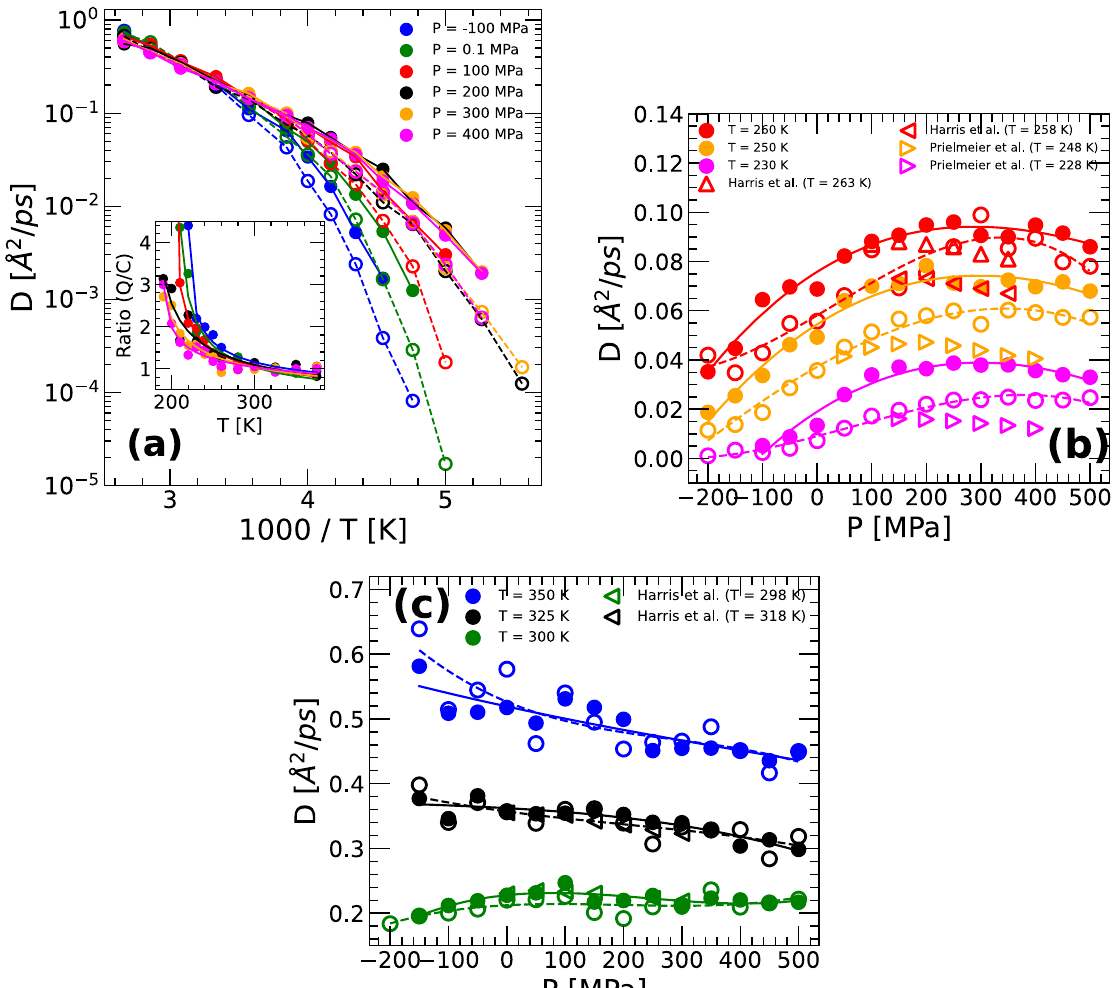
Figure 6. ( a ) Diffusion coefficient of q-TIP4P/F water as function of temperature at selected pressures. Results from RPMD simulations are indicated by solid circles; empty circles are results from classical MD simulations. Inset: ratio of the diffusion coefficients obtained from RPMD and MD simulations shown in the main panel. The inclusion of NQE increases water dynamics upon supercooling. ( b , c ) Diffusion coefficients of q-TIP4P/F water as function of pressure obtained from RPMD (solid circles) and classical MD simulations (empty circles); empty triangles correspond to experimental data (left-triangles and right-triangles from Refs. 70,71 , respectively).